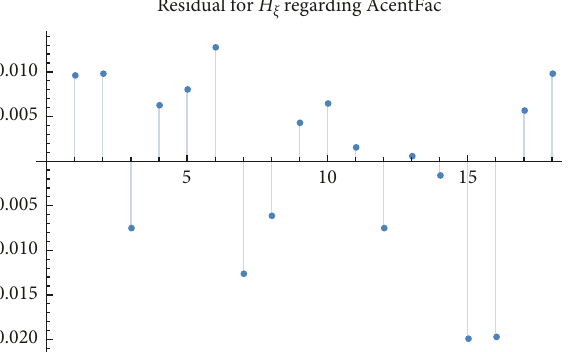
Figure 12: Plot shows the residuals for AcentFac on H